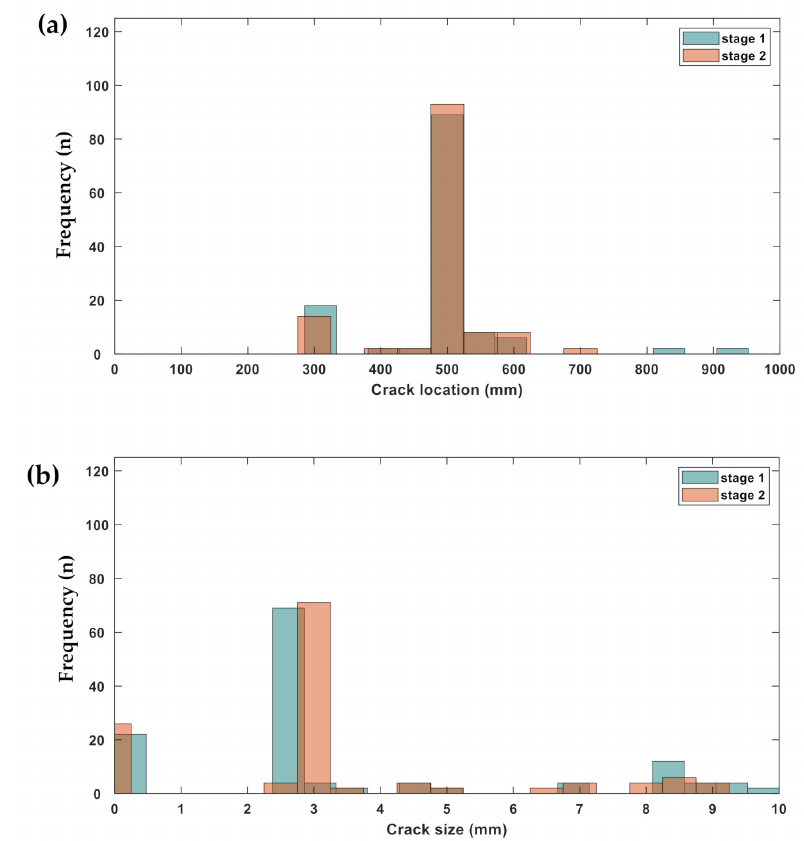
Figure 6. Frequency diagrams of ( a ) crack location and ( b ) crack size for Case